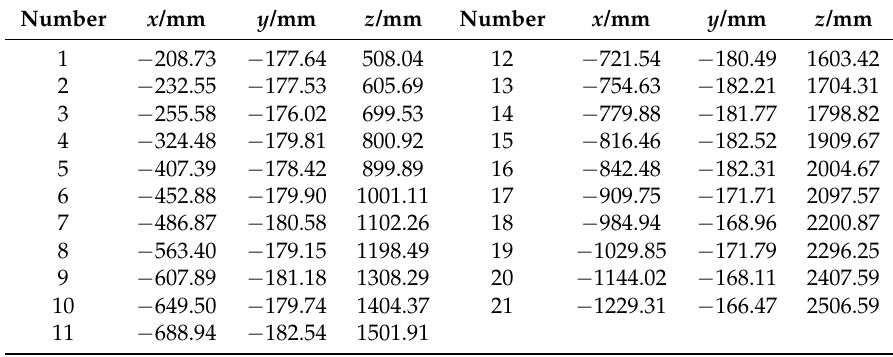
Table 5. The ground truth of the static target